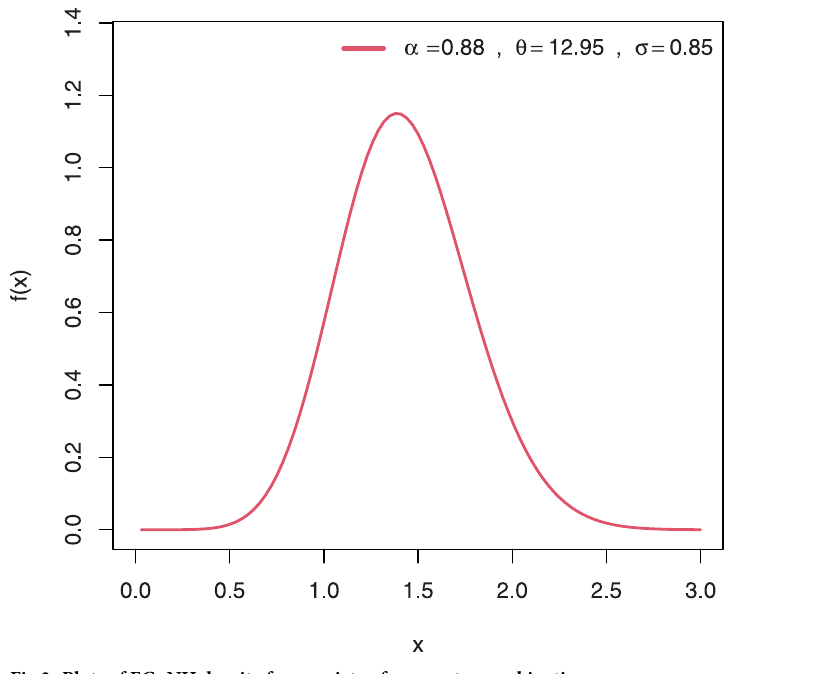
Fig 3. Plots of EGuNH density for a variety of parameter combinations.